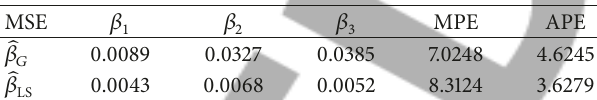
Table 1: Simulation results of estimation and prediction for Exper- iment 1 with 𝑚 = 10 and 𝑛 = 10